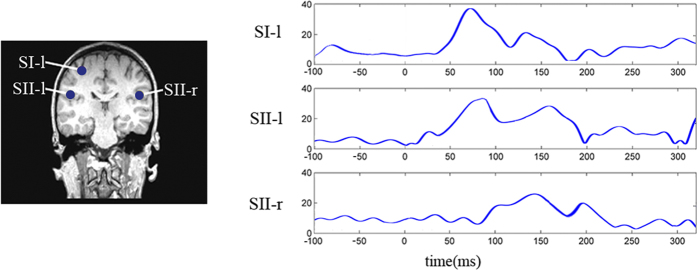
Representative source locations and the corresponding grand average source time courses of somatosensory MEG responses from all participants are presented.